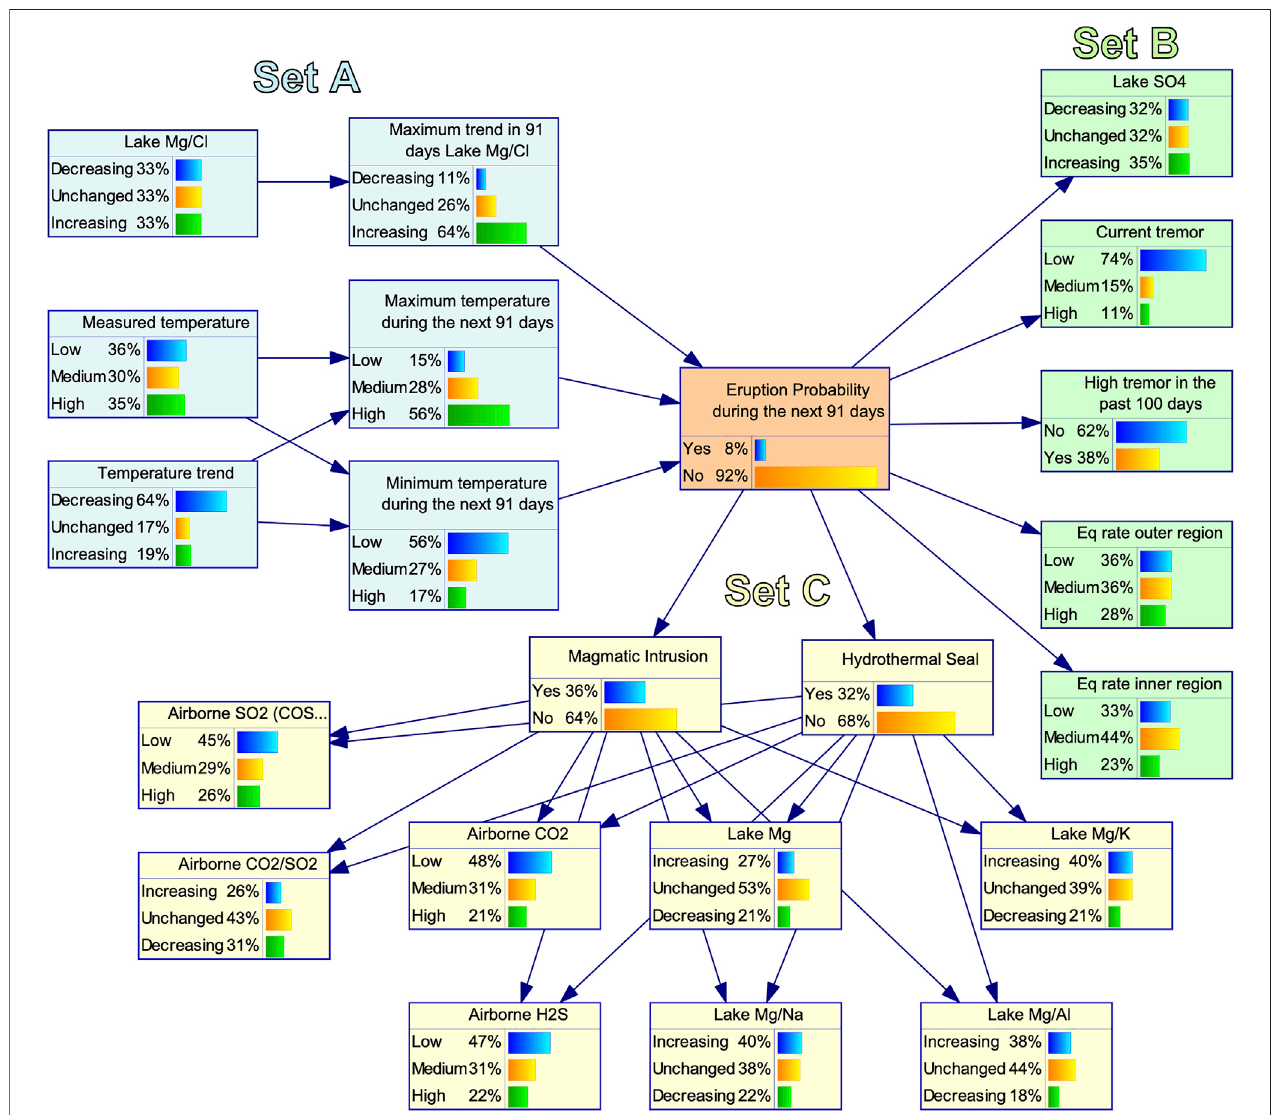
FIGURE 7 | The BN model to forecast the probability of eruption to impact beyond the rim of the crater lake during the next 91 days. The orange node represents Eruption. The blue nodes (Set (A) ) represent monitoring data with a long observation period that could be used jointly with the Eruption node to learn the CPTs from the data. The green nodes (Set (B) ) represent monitoring data, which had not suf fi cient observations when an eruption occurred so that only the condition of no eruption couldbelearnedfromdata.TheCPTentriesfortheconditionthataneruptionoccurredwereelicitedfromexperts.Theyellownodes(Set (C) )representtwohidden nodes and geochemical observations, for which the CPTs were fully elicited by members of the VMG.